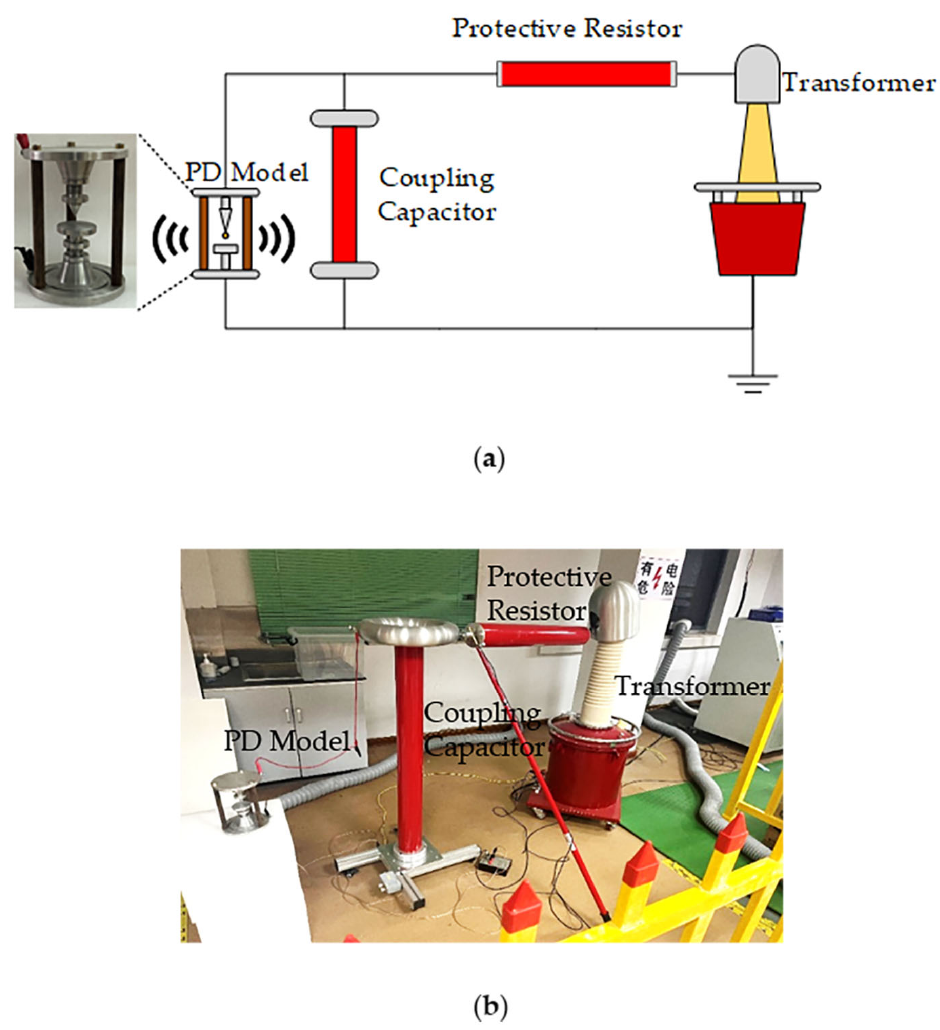
Figure 9. ( a ) The schematic diagram of PD test platform. ( b ) PD experiment